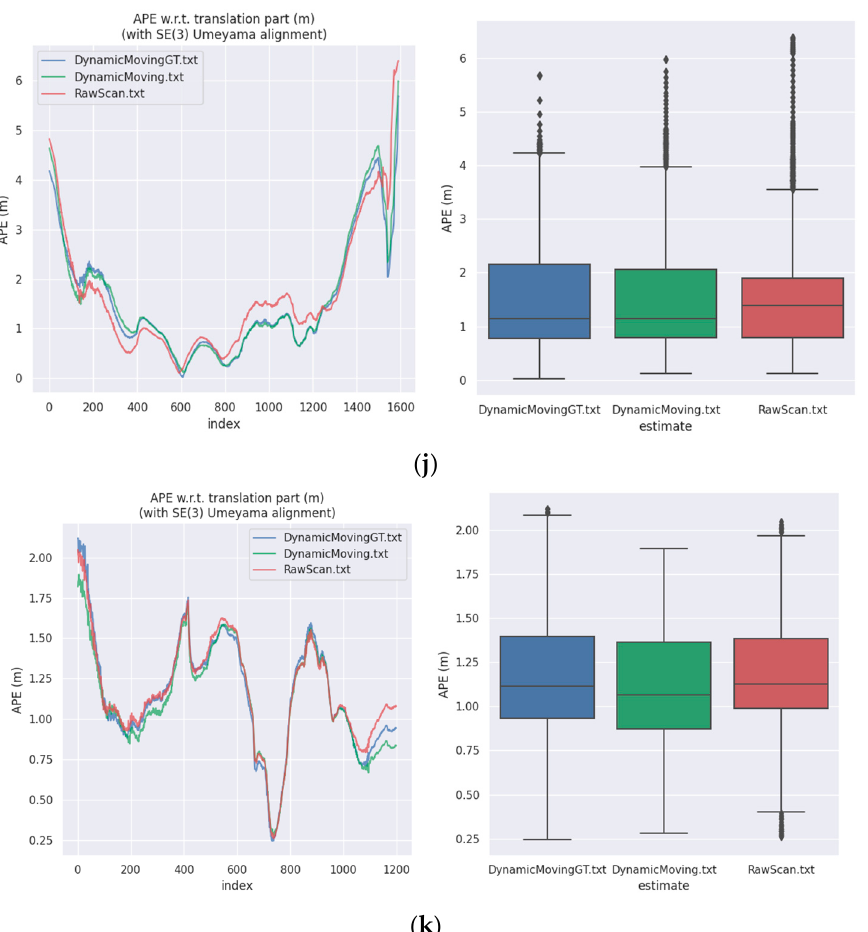
Figure 11. Experimental results of MULLS on the SemanticKITTI dataset. ( a ) Sequence 00. ( b ) Sequence 01. ( c ) Sequence 02. ( d ) Sequence 03. ( e ) Sequence 04. ( f ). Sequence 05. ( g ) Sequence 06. ( h ) Sequence 07. ( i ) Sequence 08. ( j ) Sequence 09. ( k ) Sequence 10.